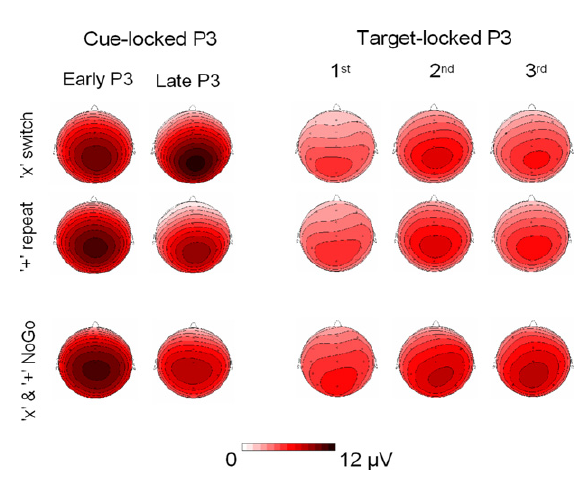
Figure 7. Scalp topography of cue-locked P3 and target-locked P3 amplitudes in the Switch (upper 2 rows) and NoGo tasks (lower row, with ‘x’ and ‘+’ trials collapsed). The topographic maps for cue-locked P3 activity were computed from the mean voltages of early P3 (325–375 ms) and late P3 (400–450 ms), respectively. Topographic maps for target P3 activ- ity (325–375 ms) are displayed for the 1st, 2nd, and 3rd target trials following a black